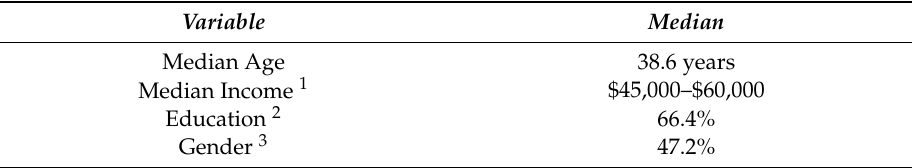
Table 3. Summary Statistics of First and Second Round surveys.